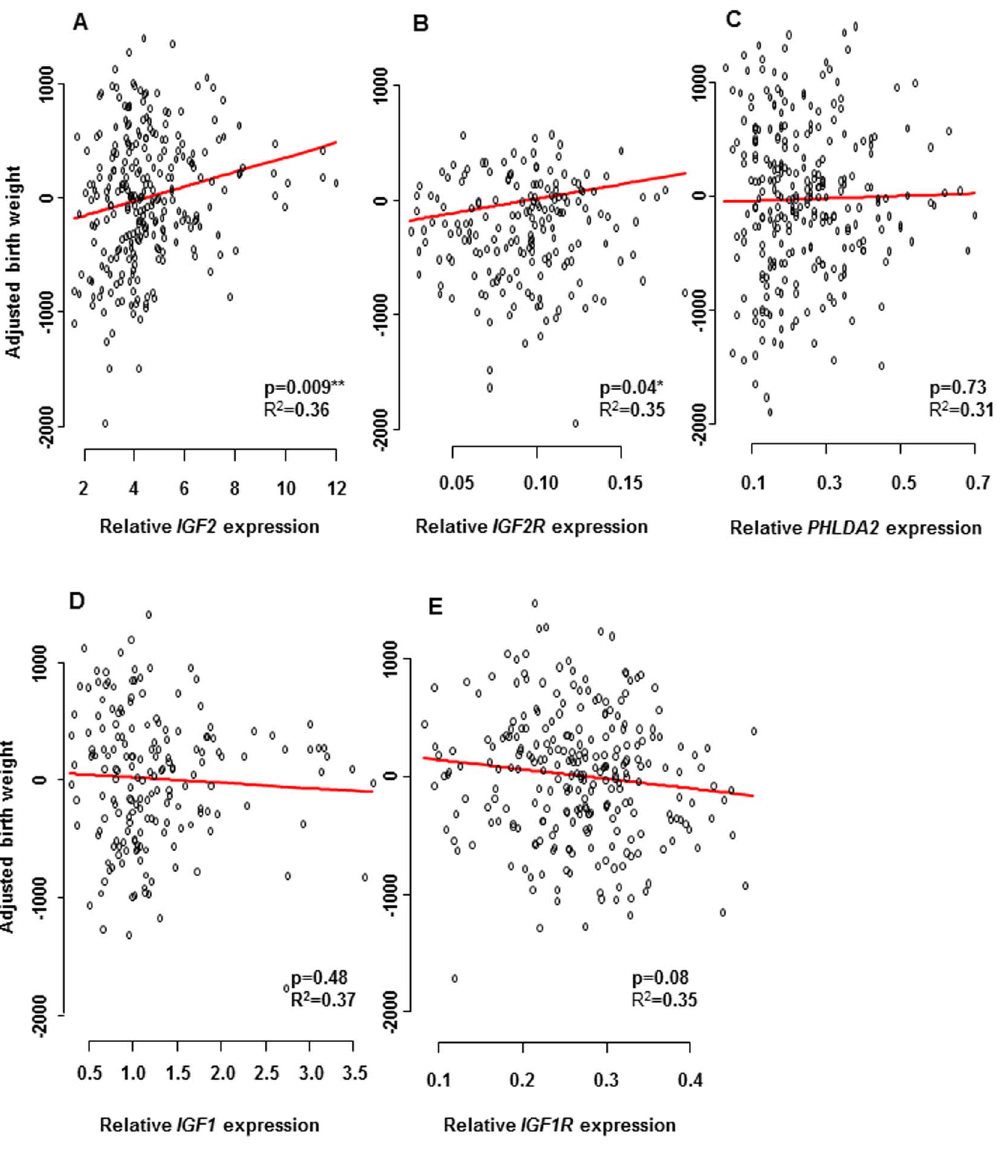
Figure 1. mRNA expression levels of IGF2 , IGF2R , PHLDA2 , IGF1 and IGF1R in chorionic villi. The expression levels of IGF2 , IGF2R , PHLDA2 , IGF1 and IGF1R after standardization to the endogenous control gene L19 , in relation to birth weight corrected for parity, sex, GA at term, maternal BMI and smoking status. Significant associations were observed for CVS expression of A) IGF2 (p=0.009) and B) IGF2R (p=0.04). No significant association was found for C) PHLDA2 (p=0.73), for D) IGF1 (p=0.48) or for E) IGF1R